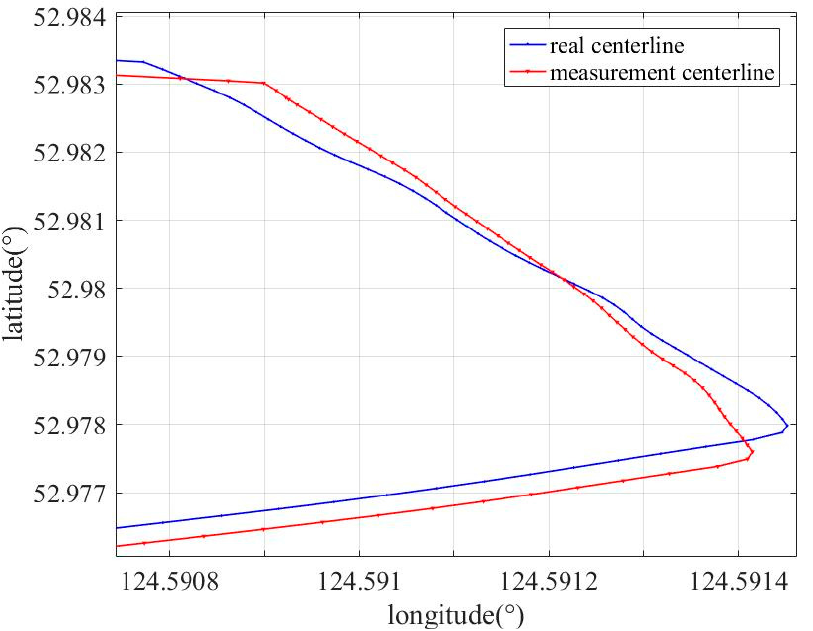
Table 2. Error between measured point and actual point when odometer slips.